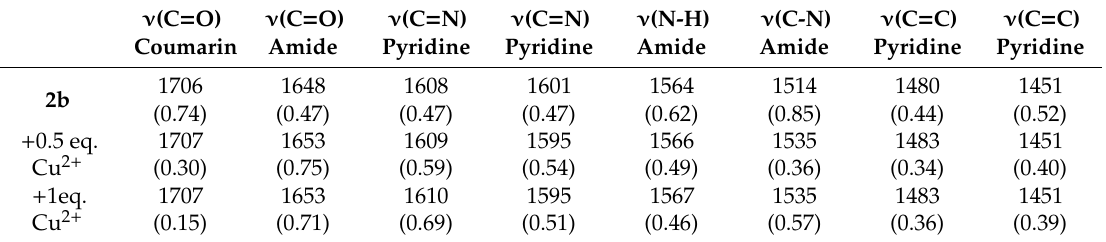
Figure 8. Normalized ATR-FTIR spectra of 2b (black line) and 2b -Cu 2 + complex formed upon the addition of 0.5 eq. (red line) and 1 eq. (blue line) of CuCl 2 to 2b (30 µ M) in DMSO / HEPES bu ff er. Table 3. Characteristic ATR-FTIR peaks and their intensities (in brackets) for 2b before and after coordination of Cu 2 +